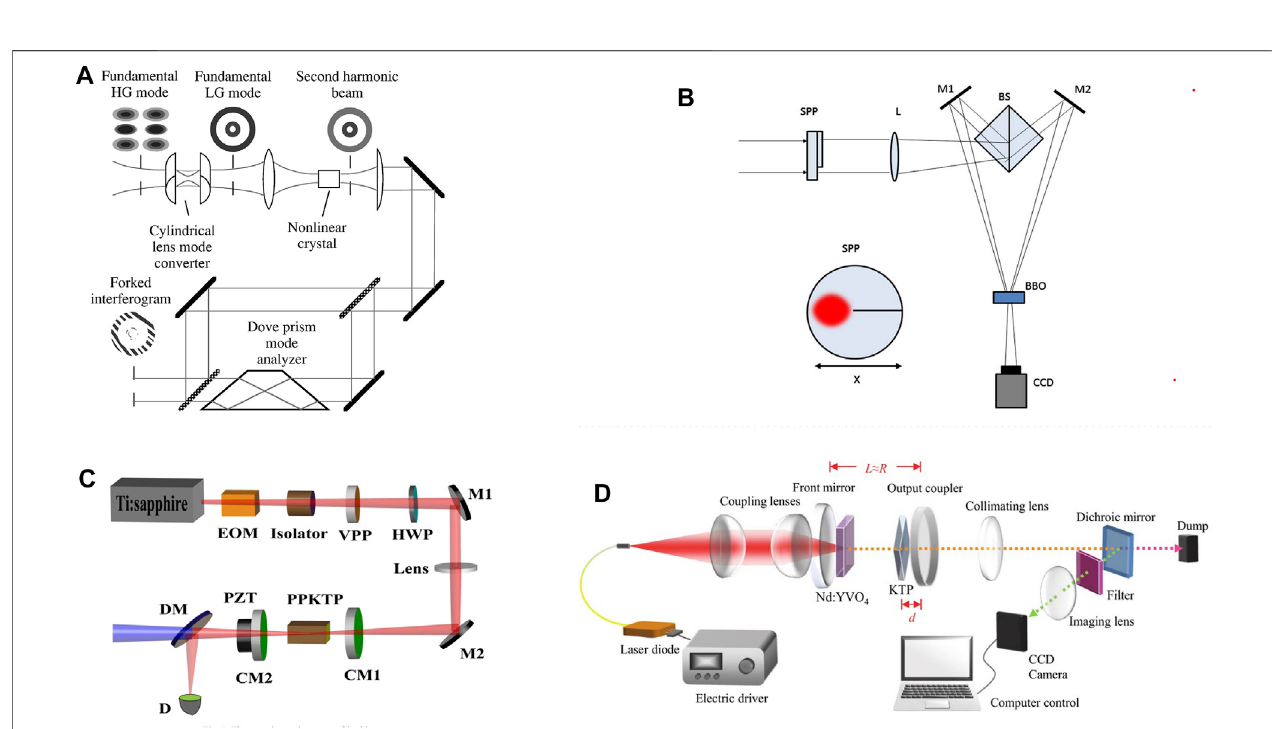
FIGURE 2 | Generalization of various methods that gives rise to a direct vortex mode without extra-cavity components.